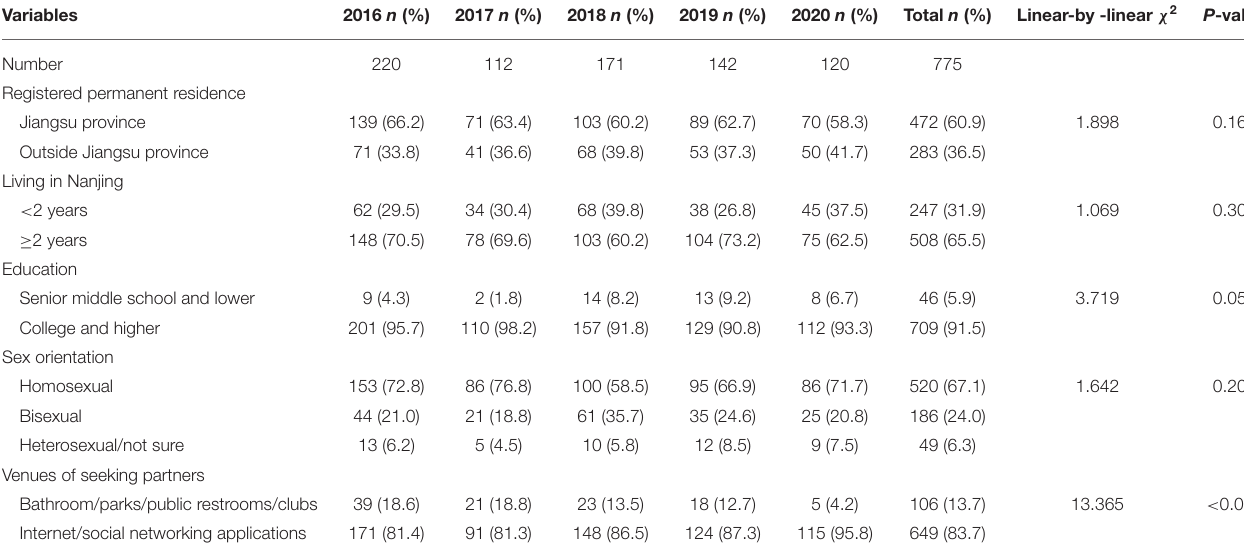
TABLE 1 | Socio-demographic characteristics among SMSM in Nanjing, China, 2016–2020.